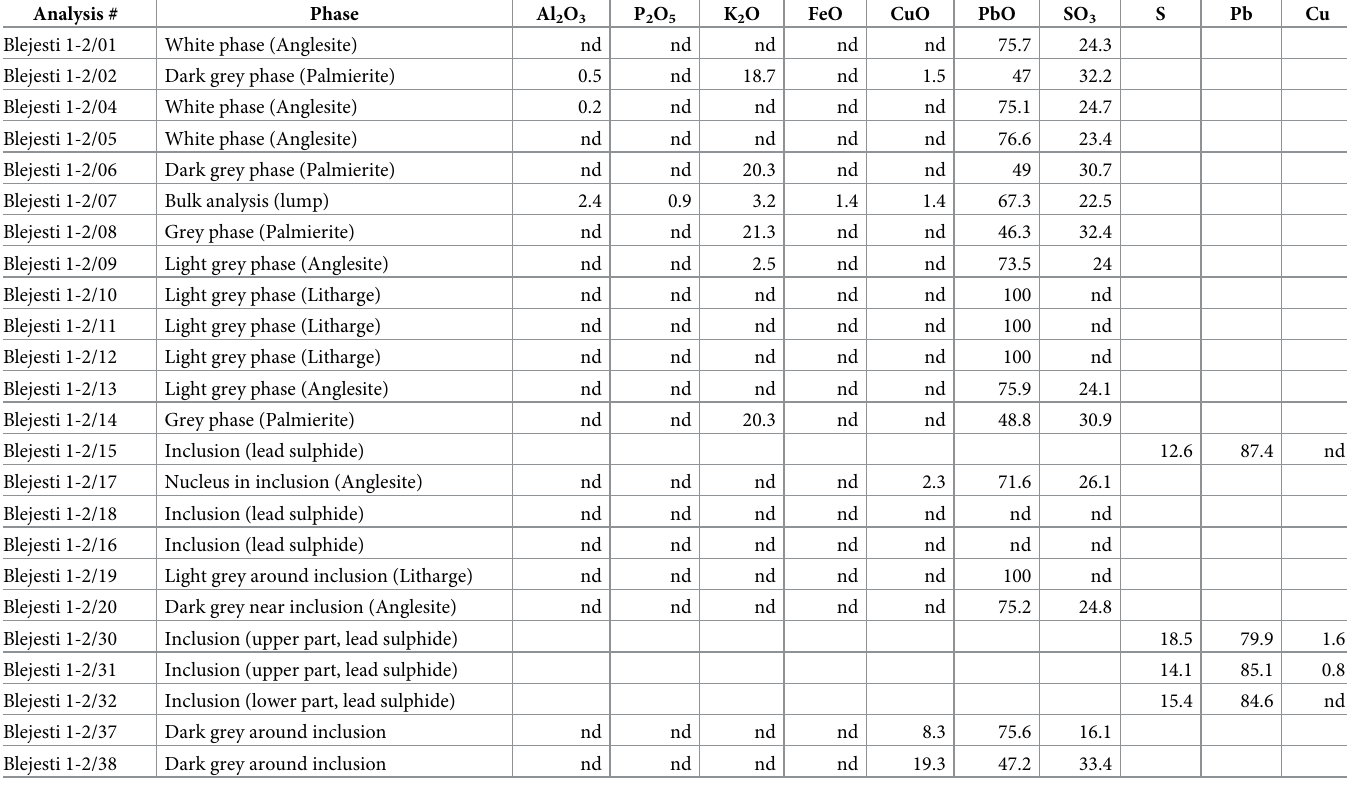
Table 2. Phase compositions of the leaded lump Bleje ş ti